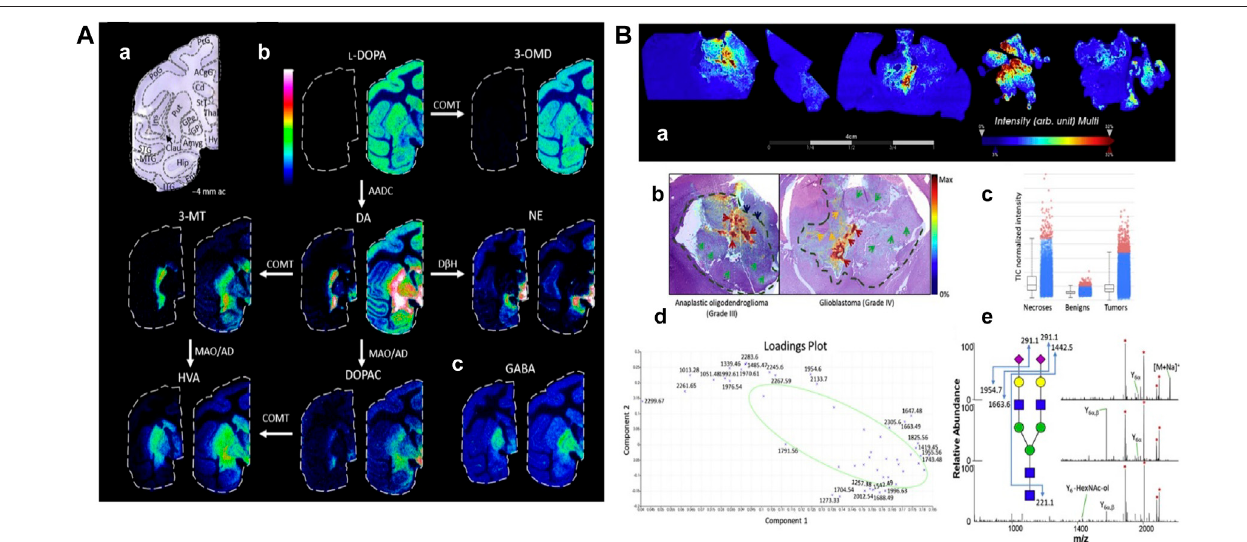
FIGURE 8| Mapping typical molecular distributions of (A) neutrotransmitters, (B) N-glycoproteomes. (A) MALDI-MS images of neurotransmitters and metabolites in non-LID and LID. (a) Nissl-stained macaque brain tissue section at − 4 mm ac with annotated brain regions. (b) Catecholaminergic metabolic pathway. (c) GABA (Fridjonsdottir et al., 2021). (B) Spatially resolved N-glycansby MALDI-MSI. (a) Summed ion images ofNa + and K + adductsof HexNAc 4 -Hex 5 -NeuAc 2 on canine glioma biopsies. (b) Superposition of MALDI-MSI glycan images with H&E-stained adjacent sections. Arrows and dashed lines indicate regions annotated by the pathologist. (c – e) Normalized intensity of total ion signals, PCA analysis, and MS n spectra of HexNAc4-Hex5-NeuAc2 (Malaker et al., 2021).